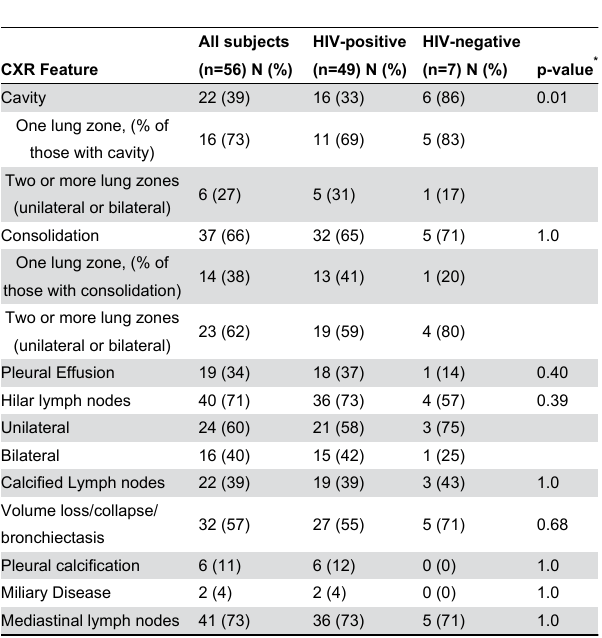
Table 2. Characteristics of baseline chest radiographs.